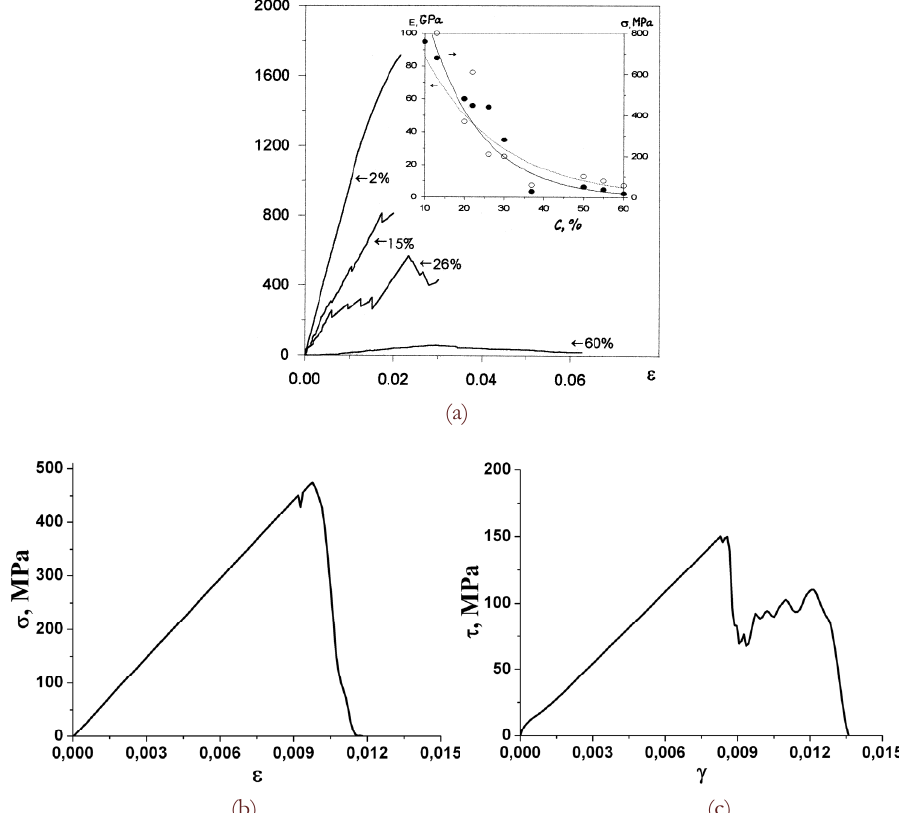
Figure 4: Experimental loading diagrams of ZrO 2 ceramic specimen with different value of porosity under uniaxial compression (a) [2] and corresponding diagrams obtained from numerical simulation (b and c) [9].